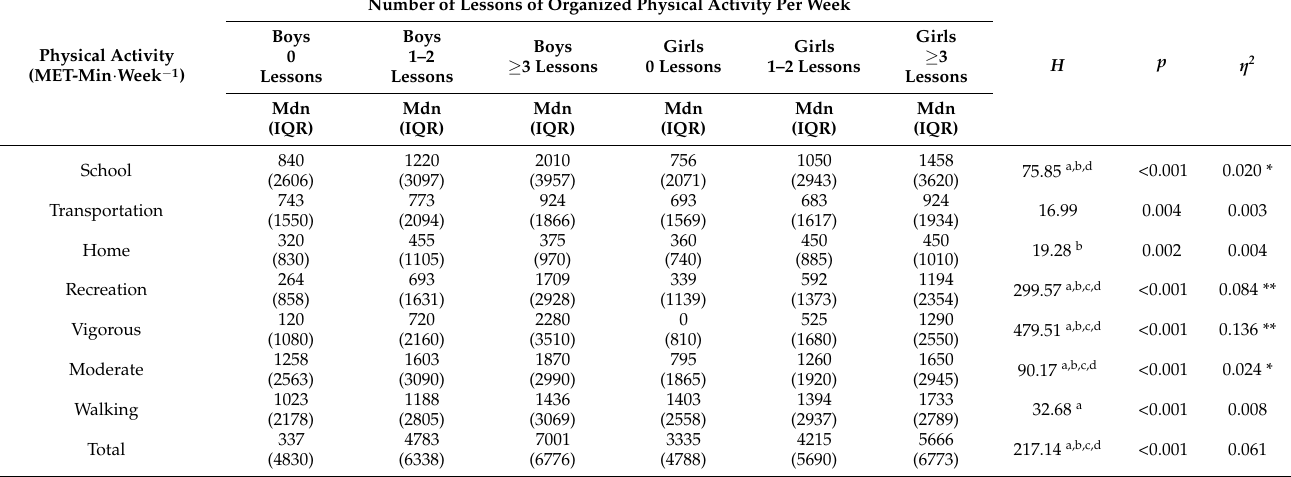
Table 4. Weekly physical activity (MET-min · week − 1 ) among boys and girls according to participation in organized physical activity